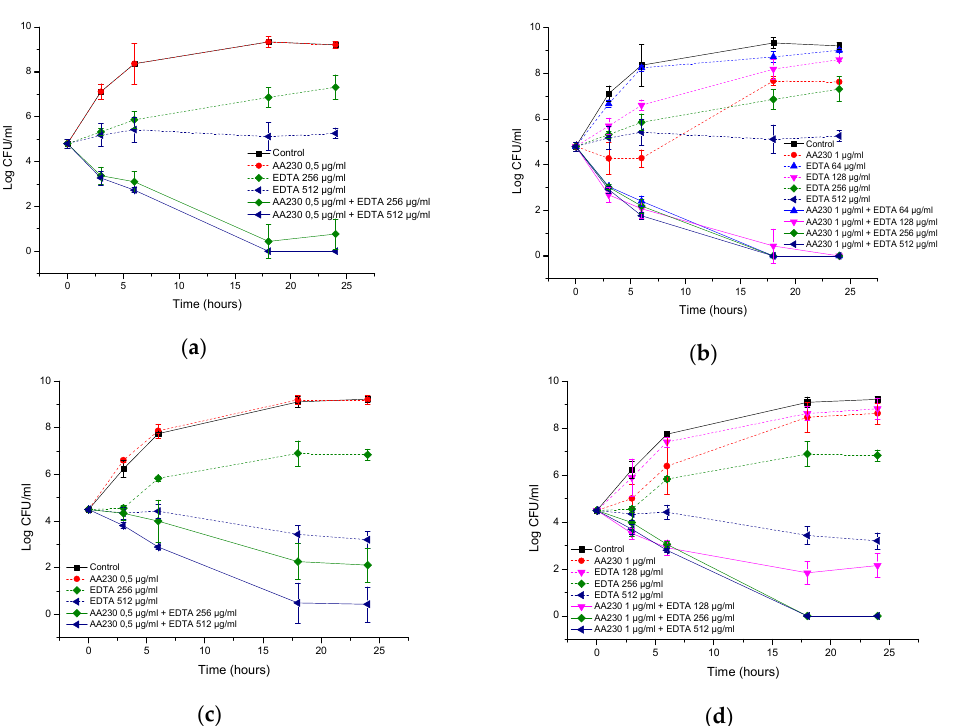
Figure 8. Time-kill curves of antimicrobial peptide AA230 and EDTA used alone and in combination against ( a , b ) Acinetobacter baumannii ATCC; ( c , d ) Acinetobacter baumannii RCH.